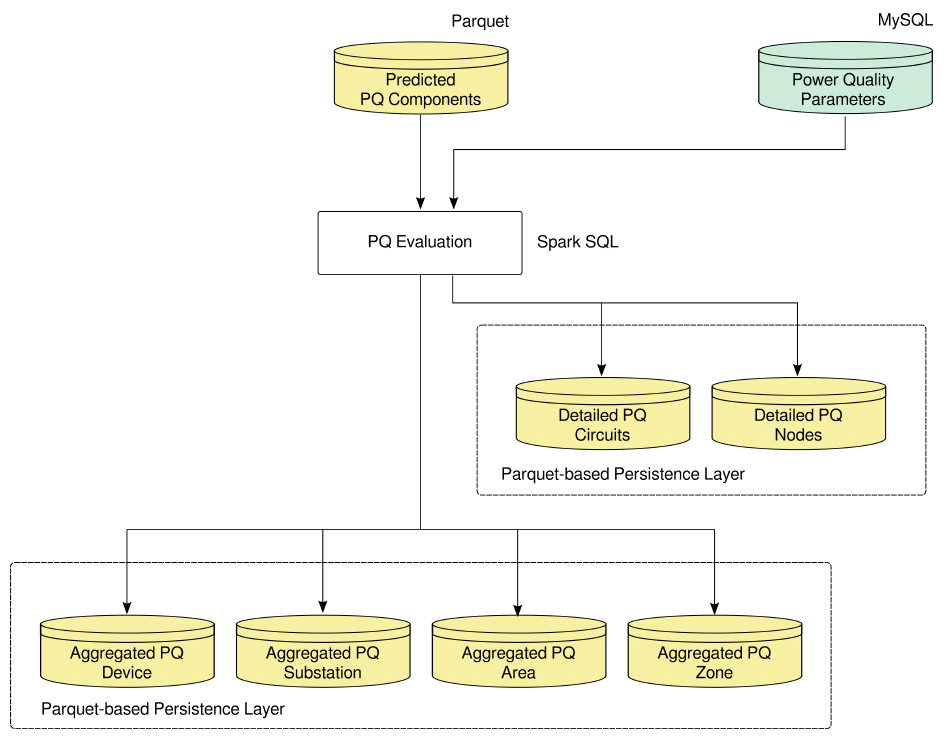
Figure 6. Power-quality-evaluation component of MIRD. Detailed PQ indexes persist for both distribution circuits and quality-control nodes. MIRD aggregates the PQ indexes at the four-level geographical hierarchy used in CFE-DCO: PQM or device, substation, area, and zone.